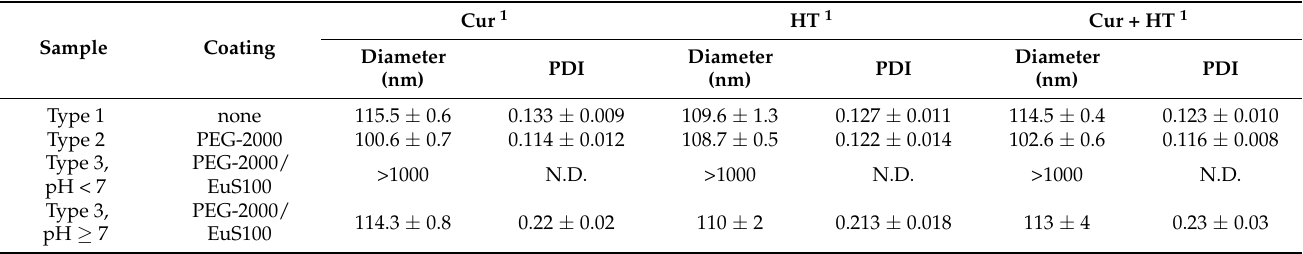
Table 1. DLS measurements of Types 1–3 liposomes loaded with Cur, HT, and Cur + HT.